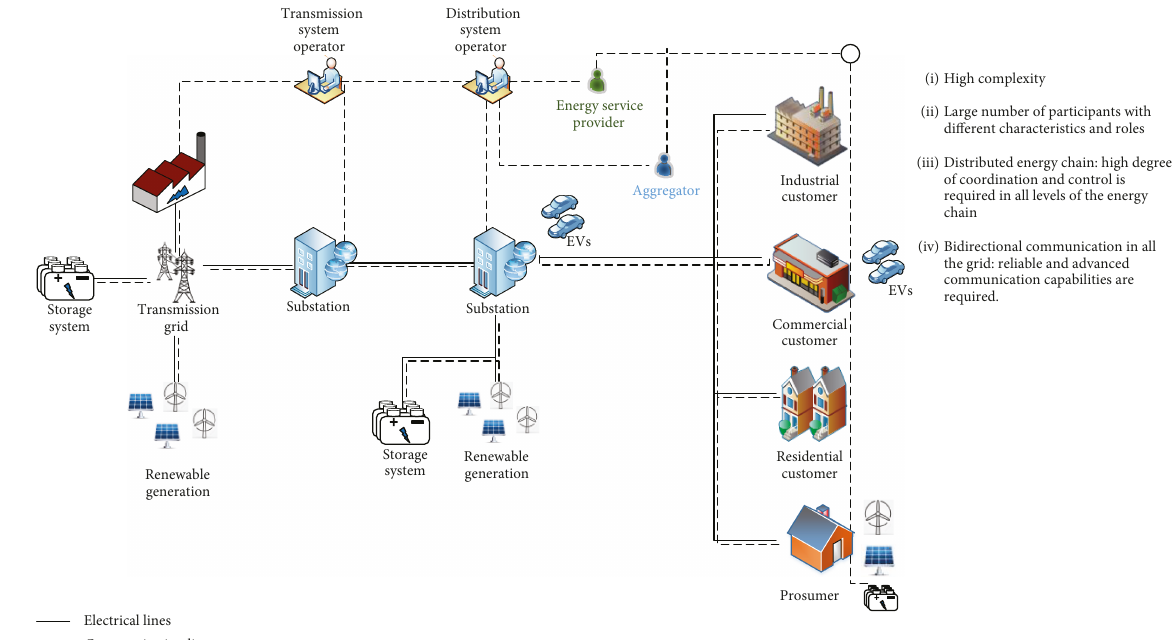
Figure 2: The present and future of the electricity grid. The so-called smart